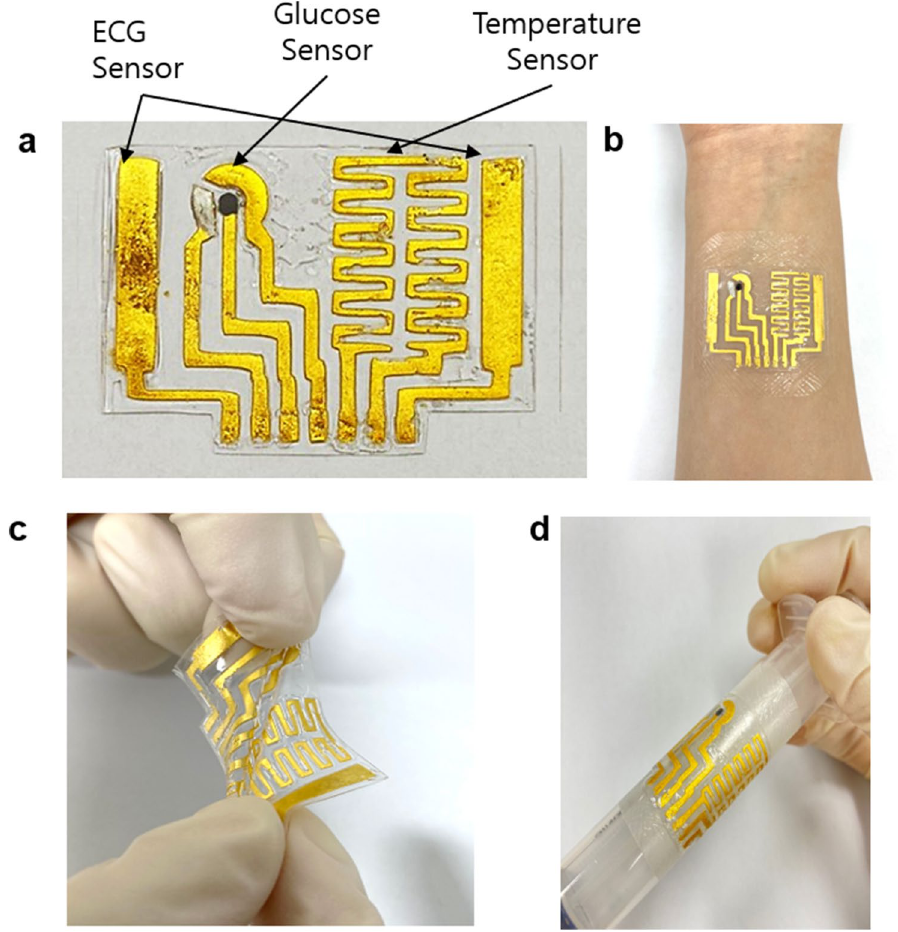
Figure 1. Fabricated flexible and stretchable wearable patch-type sensor. ( a ) Multi-functional physiological monitoring capability for ECG, glucose, and temperature sensing on a 40 mm × 25 mm PDMS patch. ( b ) The sensor is conformally attached on the skin around the wrist. ( c ) The sensor can be twisted and stretched with mechanical robustness. ( d ) The sensor can be conformally wrapped around a syringe with a diameter of 17